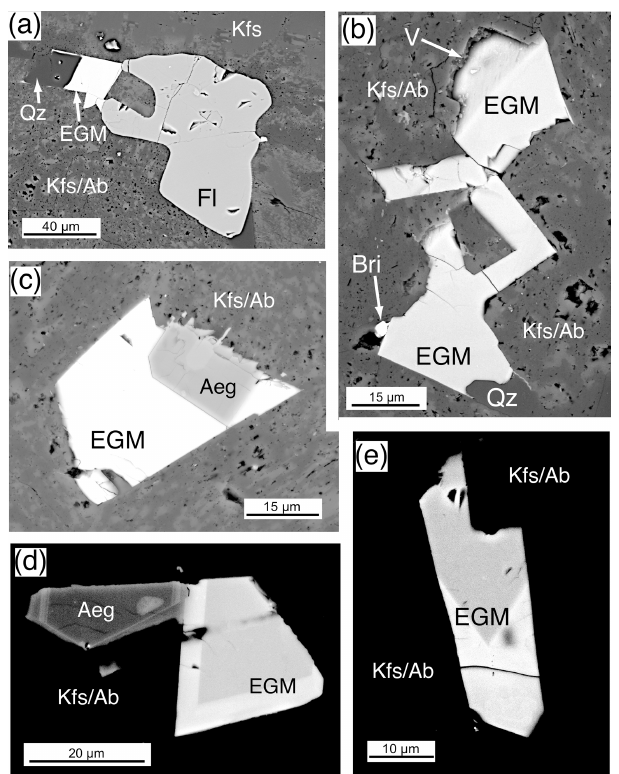
Figure 15. Eudialyte-group mineral (EGM), BSE images from sam- ple DV24828 Ailsa Craig microgranite. (a) A 20µm EGM adjacent to fluorite (Fl) that filled an open space with quartz (Qz) enclosed by K-feldspar and albite (Kfs / Ab). (b) A 75µm group of EGM filling a large open space in K-feldspar and albite (Kfs / Ab). The EGM ap- pears coeval with quartz (Qz) and was followed by britholite (Bri). The sample preparation has exposed a vug (V). (c) A 22µm EGM that has grown over a euhedral Zr-bearing aegirine (Aeg) enclosed by K-feldspar and albite (Kfs / Ab). (d) A 23µm zoned EGM ad- jacent to a Zr-bearing aegirine (Aeg) enclosed by K-feldspar and albite (Kfs / Ab). The contrast in this image and in (e) has been ad- justed to show the zoning. The bright rim has high REEs and lower Na 2 O than the darker portion. (e) A 45µm zoned EGM filling an open space enclosed by K-feldspar and albite (Kfs / Ab). The com- position of the bright and dark portions is given in Table 13; the bright part has high REEs and lower Na 2 O than the darker portion.